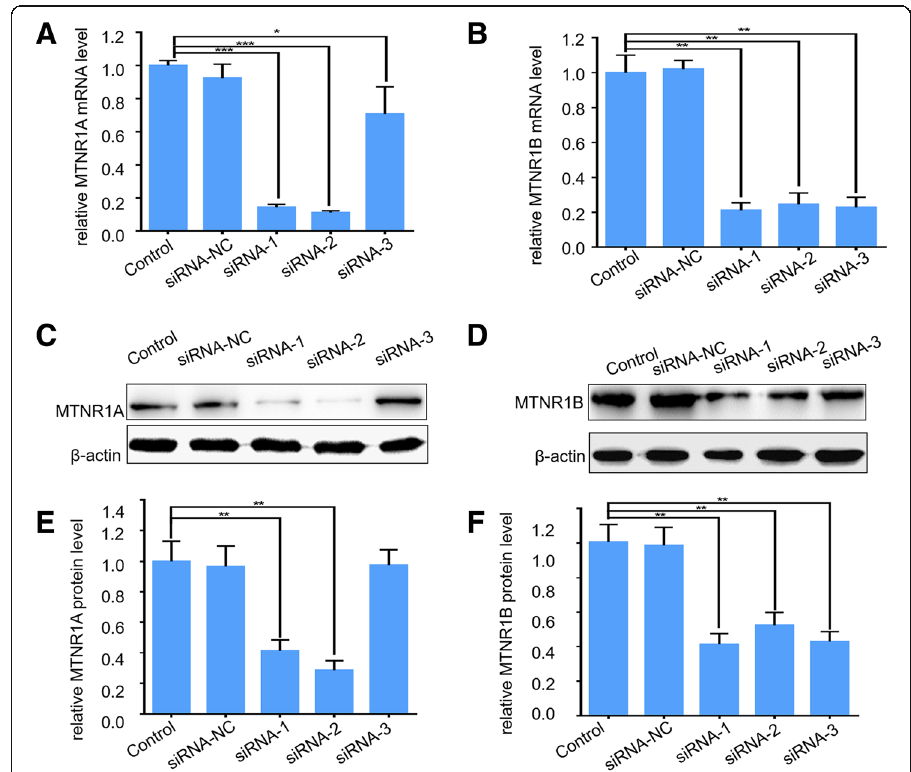
Fig. 2 siRNA-mediated knockdown of MTNR1A and MTNR1B in mLTC-1 cells. a and b . qPCR assay of the MTNR1A and MTNR1B mRNA levels in mLTC-1 after transfection of siRNAs against MTNR1A and MTNR1B, respectively. c and d . Western blotting results of MTNR1A and MTNR1B protein levels in mLTC-1 after transfection of siRNAs against MTNR1A and MTNR1B, respectively. e and f . The intensity of WB bands in C and D was evaluated with ImageJ. Data are presented as mean ± SEM of triplicate experiments. * P < 0.05, ** P < 0.01, *** P < 0.001 (Student ’ s